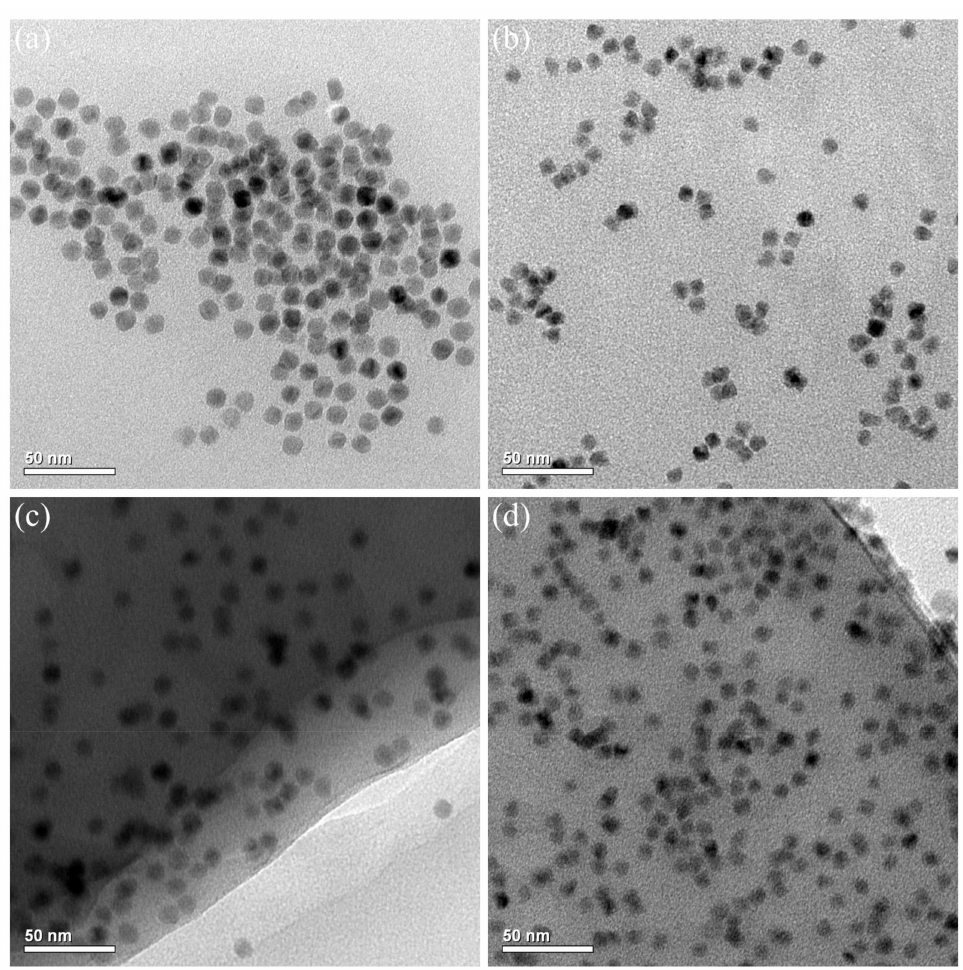
Figure 5. TEM images illustrating the morphologies and distribution state of red QDs ( a , c ) and green QDs ( b , d ) before DLW polymerization ( a , b ), and after DLW polymerization ( c , d ) of QD–polymer composites with QD doping concentrations of 5 mg/mL using the applied P of 33 mW for ( c ) and 31 mW for ( d ) at the v of 100 µ